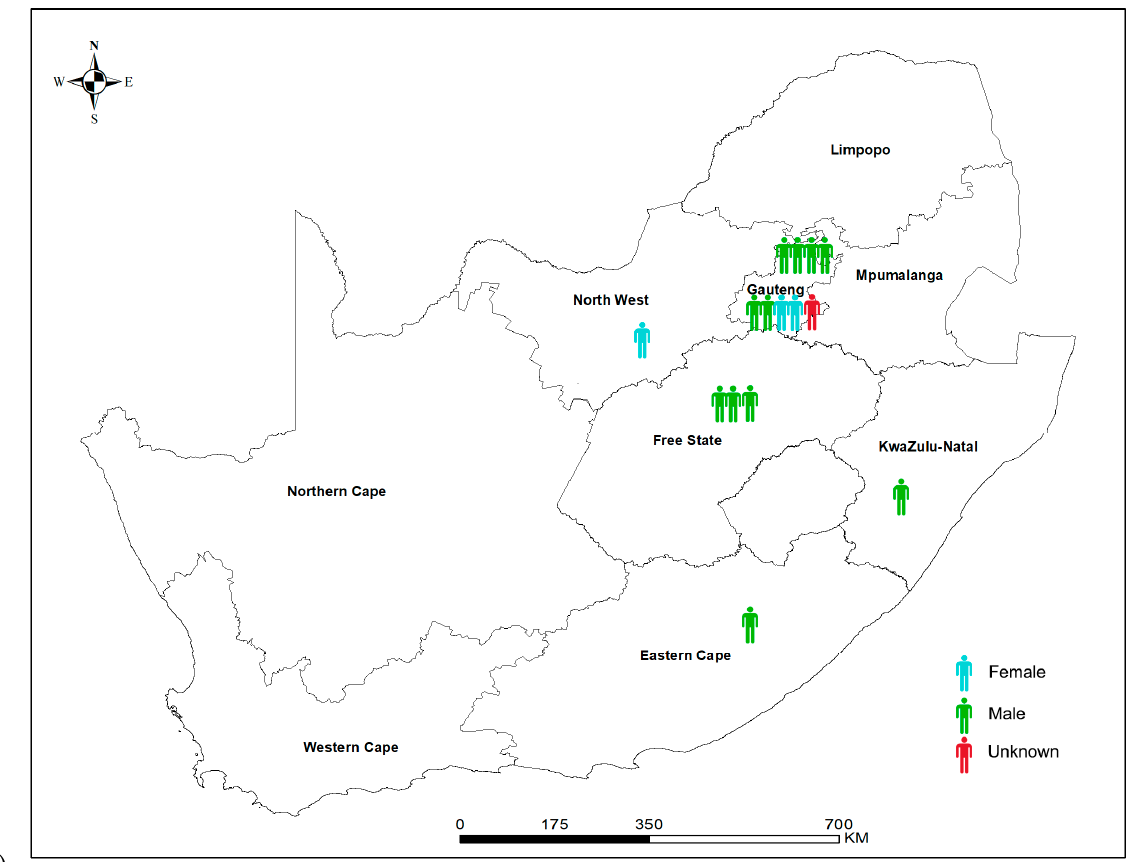
Figure 4. ( a ) WGS SNP analysis of 15 South African clinical Cryptococcus neoformans isolates with the VNB molecular type (green circles and bold) and 21 publicly-available clinical and environmental VNB isolates [15]. Bt 85 (VNBI) was used as the reference and Bt 1 (VNBII) was added as an external genome. BWA was used to align reads to the reference and SAMtools was used to call SNPs. There were 488,188 SNPs in total with a coverage breadth of 79% and this is a midpoint-rooted maximum parsimony tree with 500 bootstrap replicates. The bootstrap values are shown next to the branches, the consistency index was 0.39, and the number of phylogenetic sites was 488,188. GA—Gauteng, FS—Free State, EC—Eastern Cape, NW—North West, KZ—KwaZulu-Natal, M—Male, F—Female, U—Unknown, SA—South Africa, BO—Botswana, BR—Brazil. ( b ) The map shows the geographical and gender distribution of the 15 South African patients infected with C. neoformans molecular type VNB in our study.